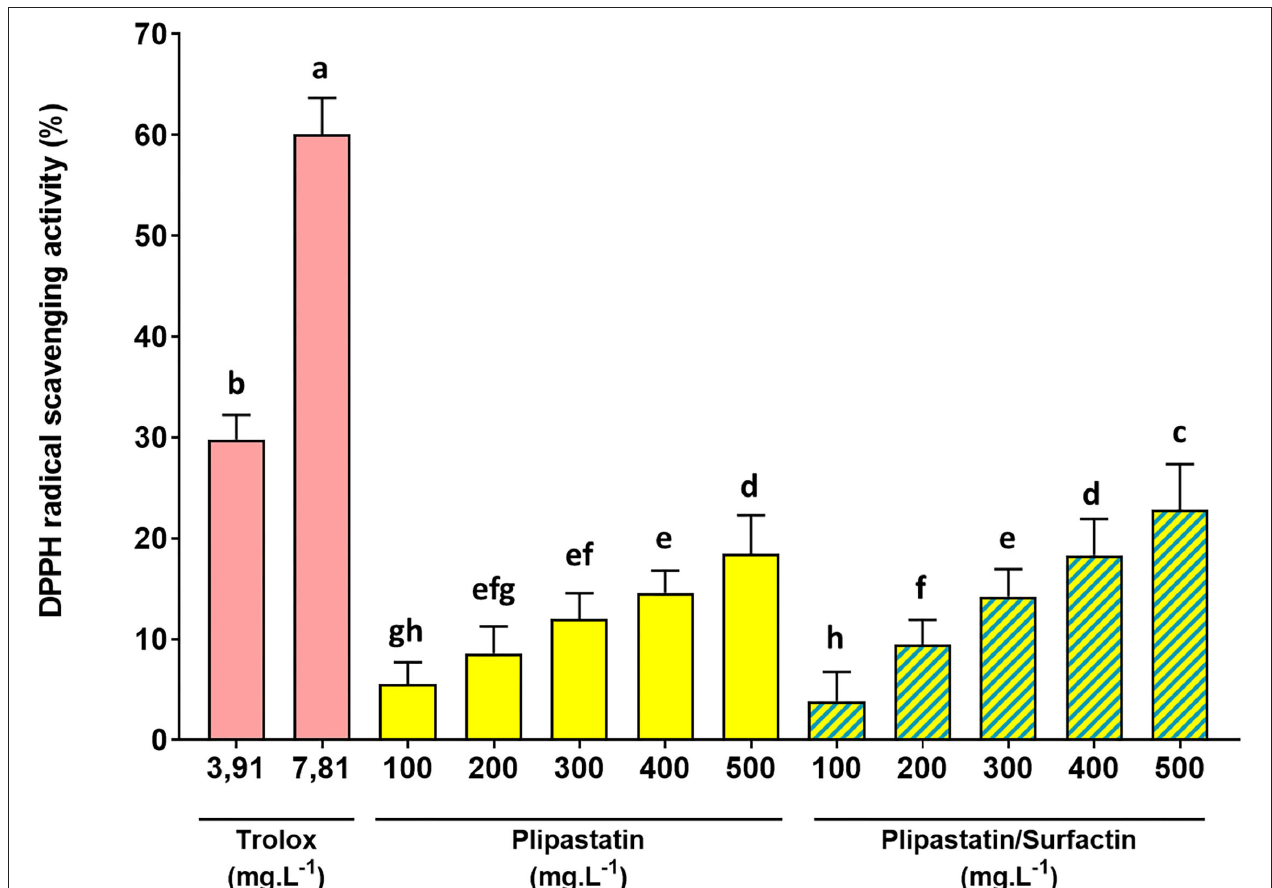
FIGURE 2 | In vitro inhibition of the DPPH radical by the lipopeptides of interest at increasing concentrations. The effects on the DPPH radical of 100 to 500mg.L − 1 of the compounds were compared (for the mixture, the indicated concentrations correspond to the concentration of each of the two lipopeptides). Trolox was used as the positive control. The DPPH radical scavenging activity was expressed as % of the negative control. Statistical analysis of the data was performed on 4 independent experiments using ANOVA (overall Fisher’s test at the p = 0.05 level) and the Tukey’s multiple a posteriori comparison test with the Graph Pad Prism software. Means without a common letter (a-h) are different ( p < 0.05). Results are presented as a bar chart with means ( n = 16) ±